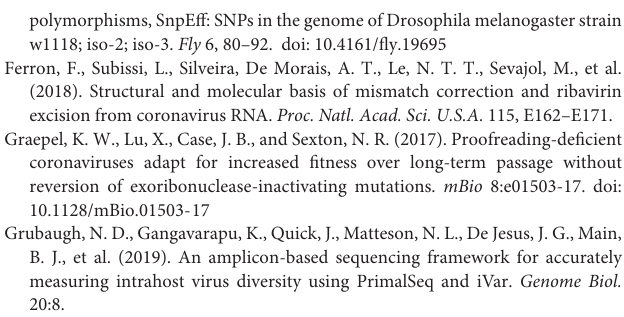
Supplementary Figure 1 | Patient demographics, transmission map and diversity of COVID-19 in India. (A–D) Represents the distribution of gender, age, clinical status and geographical location of sampled patients ( n = 225). (E–F) Transmission map and Timetree of the 1,042 high coverage Indian SARS-CoV-2 whole genome sequences ( N < 1%) obtained from GISAID on 12th July, 2020. Supplementary Figure 2 | ORF1ab Ct values in tested positive samples ( n = 637) and haplotype network of sequenced data colored by clade. (A) ORF1ab Ct values in tested positive samples ( n = 637) binned in their respective collection months. (B) Haplotype network of 202 SARS-CoV-2 whole genome sequences from our dataset colored by their respective clade. (C) Comparison of D614G mutation in global and Indian SARS-CoV-2 sequences. Supplementary Figure 3 | Maximum likelihood tree of SARS-CoV-2 genomes ( n = 202). (A) Maximum likelihood tree of SARS-CoV-2 genomes with 1,000 bootstraps and branch support values with =60 threshold. Supplementary Table 1 | Information about patients, List of single nucleotide mutations and the annotated genes, corresponding amino acid changes and its predicted impact on protein function. Supplementary Table 2 | Accession ids of GISAID